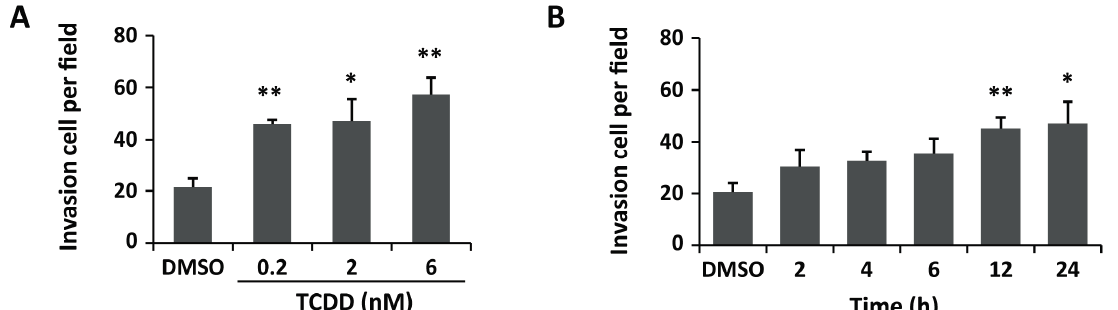
Figure 4. TCDD induced gene expression during cell invasion and